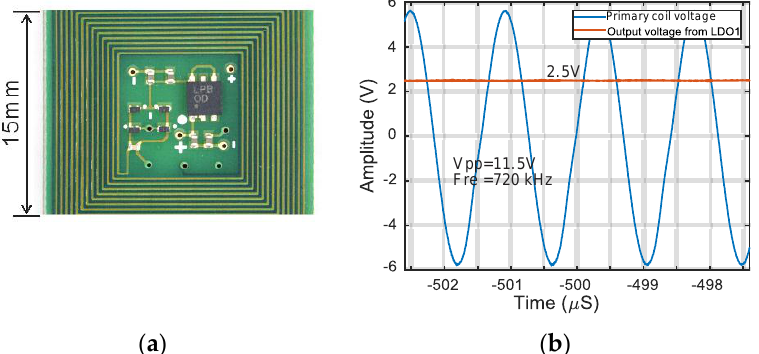
Figure 4. ( a ) A six-layer PCB (printed circuit board) for inductive power transfer testing with a full bridge rectifier and commercial low-dropout regulator (ADP7118AUJZ-2.5-R7). ( b ) Measured regulated 2.5 V DC output voltage from the PCB coil (15 × 15 mm 2 ) with a 720 kHz transmit frequency.